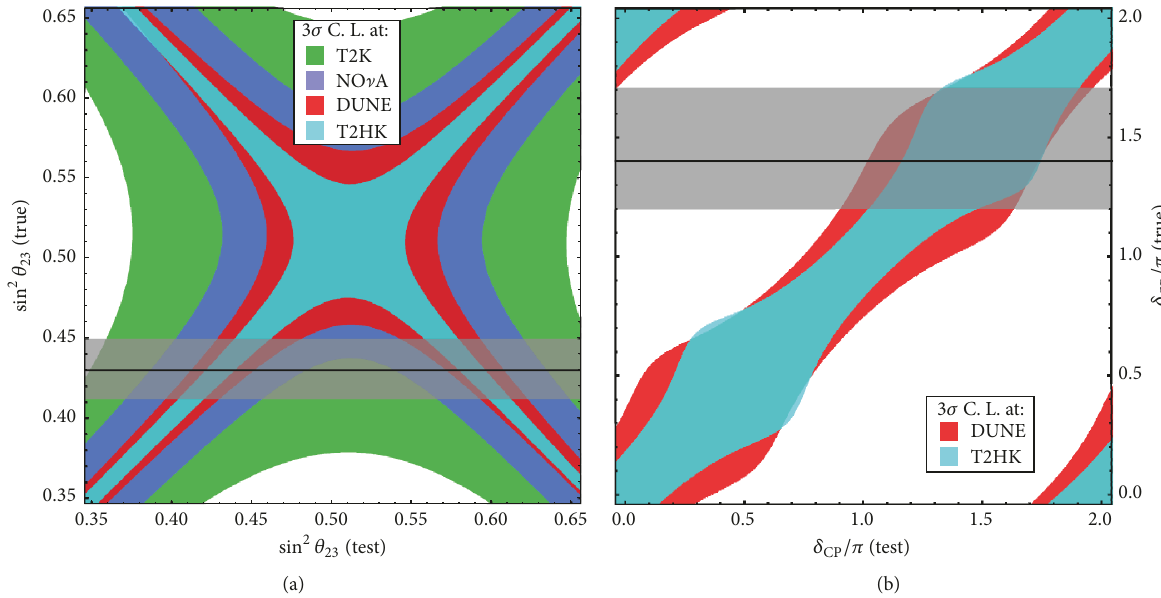
Figure 2: (a) and (b) correspond to the expected reconstruction of the oscillation parameter 𝜃 23 ( 𝛿 CP ). The black line indicates the best fit value given in Table 3 and the gray area corresponds to its 1𝜎 region. The colored areas represent the regions that the experiments cannot distinguish within more than 3 𝜎 for (1) T2K (green), (2) NO ] A (blue), (3) DUNE (red), and (4) T2HK (cyan). In (b) we did not include T2K or NO ] A as they cannot reconstruct the CP phase with more than 3 𝜎